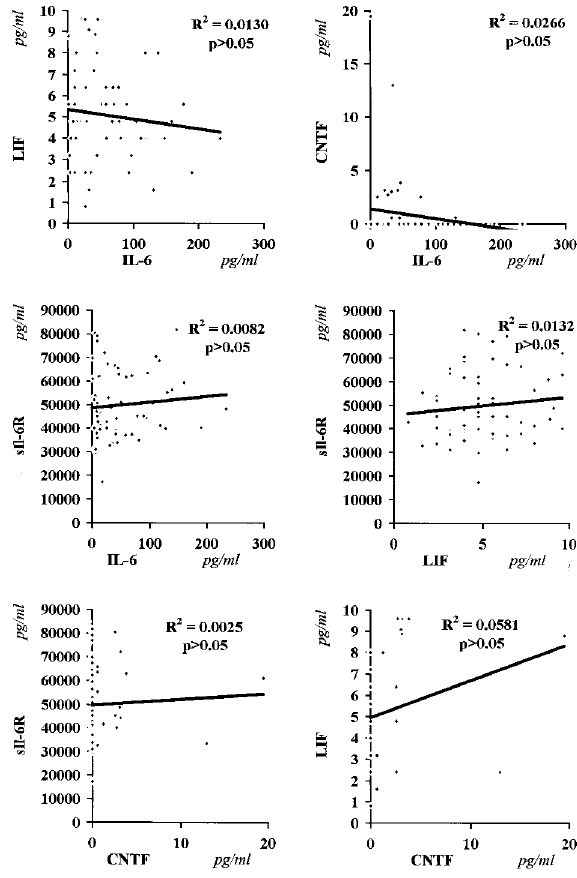
FIG. 3. Correlations between serum concentrations of IL-6R with IL-6, LIF and CNTF, IL-6 with LIF and CNTF and LIF with CNTF in patients with